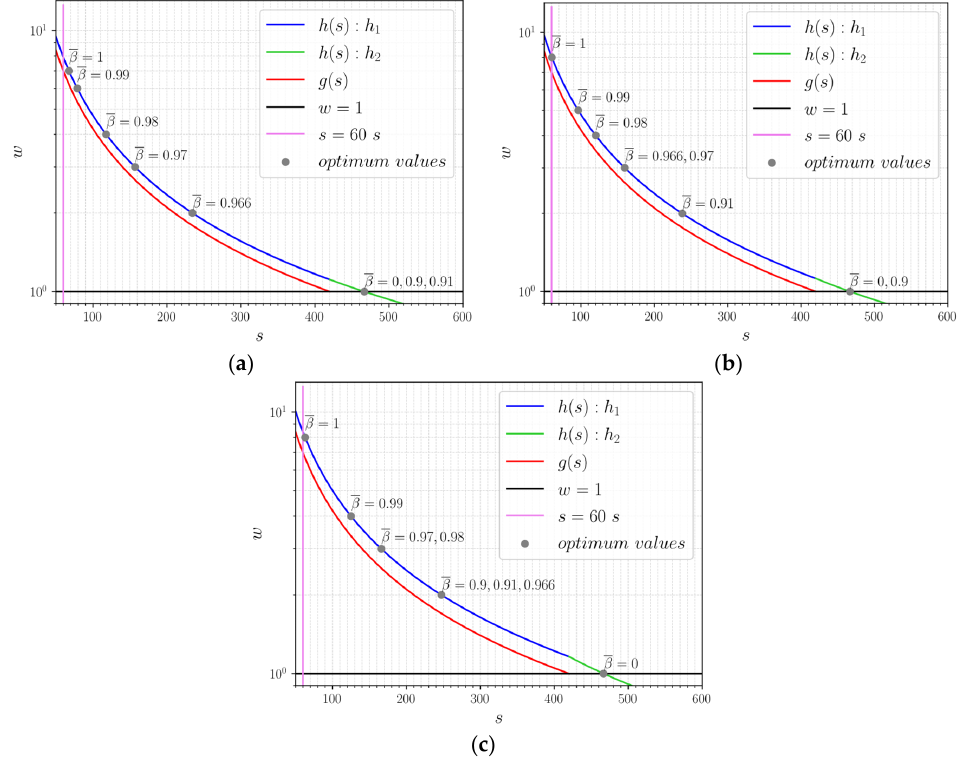
Figure 6. Optimum values of w and s for ( a ) λ = 1/90 s − 1 , ( b ) λ = 1/180 s − 1 , and ( c ) λ = 1/360 s − 1 α = 0.9, AoI α = 420 s, varying β